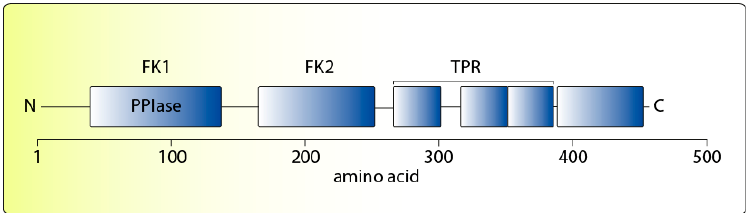
Figure 2. Schematic representation of the FKBP51 protein domain structure. TPR = tetratricopeptide repeat domain conveying Hsp90 interaction.